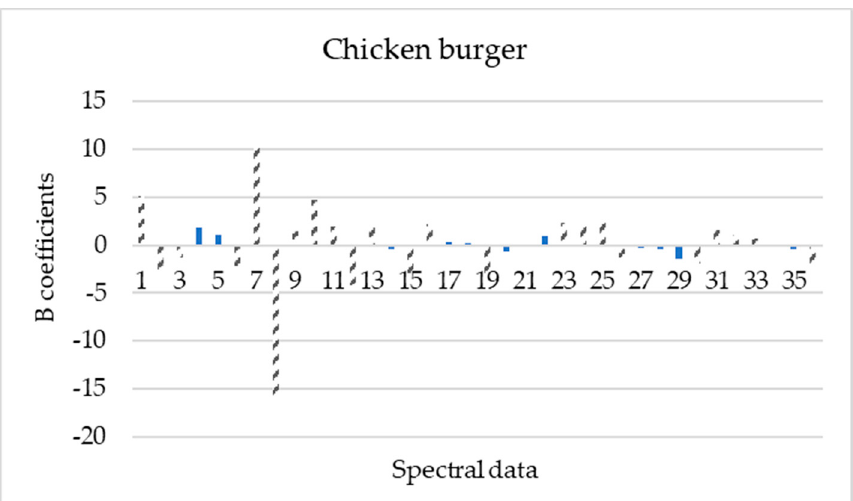
Figure 6. Spectral data (mean and standard deviation) influence (b coefficients) to PLS-R model construction for chicken burger samples. Dashed bars represent data that influenced more the model (1, 19: 405 nm; 2, 20: 435 nm; 3, 21: 450 nm; 4, 22: 470 nm; 5, 23: 505 nm; 6, 24: 525 nm; 7, 25: 570 nm; 8, 26: 590 nm; 9, 27: 630 nm; 10, 28: 645 nm; 11, 29: 660 nm; 12, 30: 700 nm; 13, 31: 850 nm; 14, 32: 870 nm; 15, 33: 890 nm; 16, 34: 910 nm; 17, 35: 940 nm and 18, 36: 970 nm).